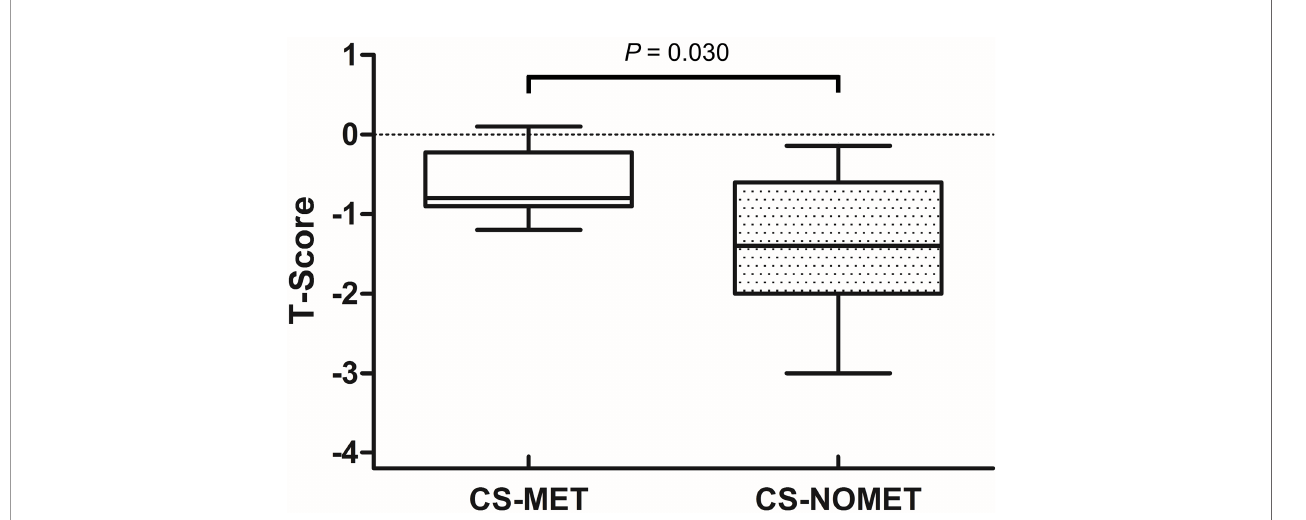
FIGURE 2 | Bone mineral density (T-Scores) in patients with fl orid Cushing ’ s syndrome (CS) and pre-existing metformin therapy (CS-MET) or without pre-existing metformin (CS-NOMET). Boxplot = median and ranges of T-Scores. CS-MET: n = 8; CS-NOMET: n = 13. Comparison between groups by Mann-Whitney-U-Test; p ≤ 0.05 was considered statistically signi fi cant.